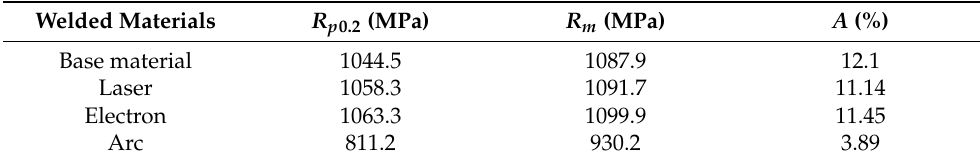
Table 7. Average values of the selected mechanical properties of the S960Ql material and its welds. Welded Materials